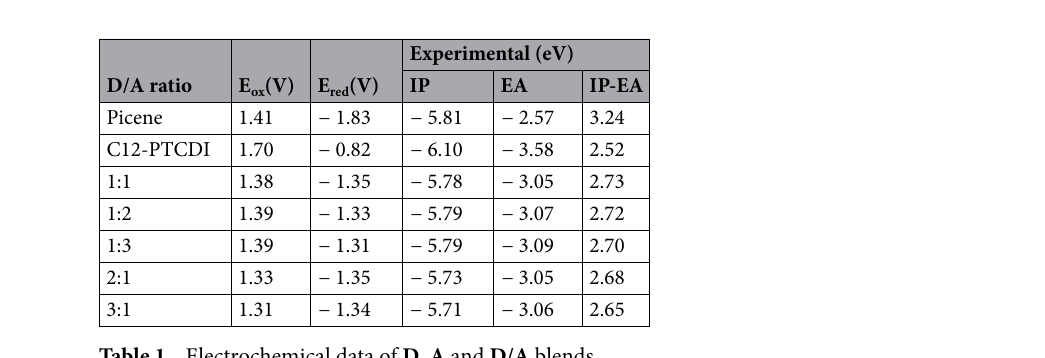
Table 1. Electrochemical data of D , A and D/A